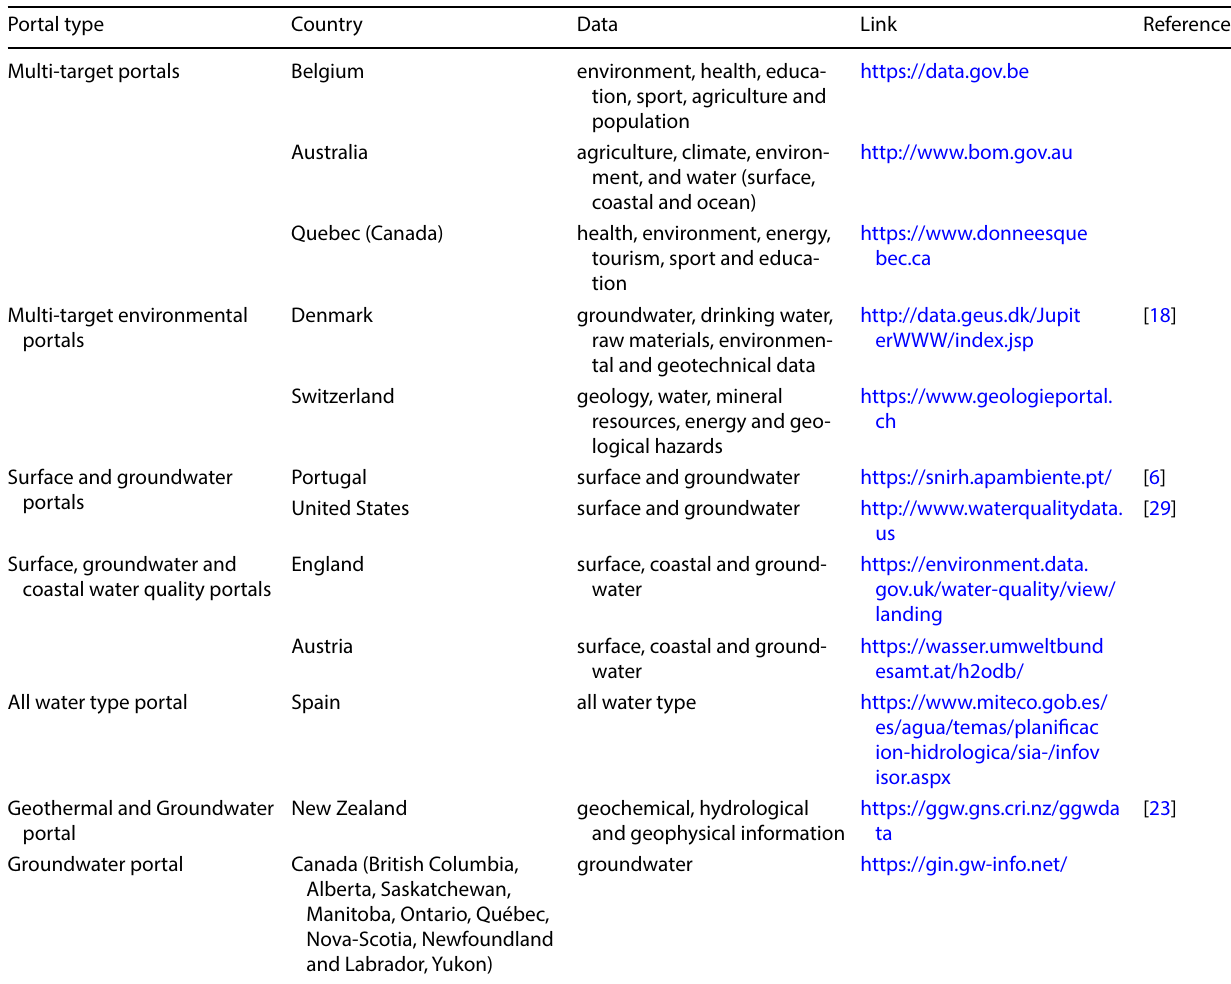
Table 1 International database examples Portal